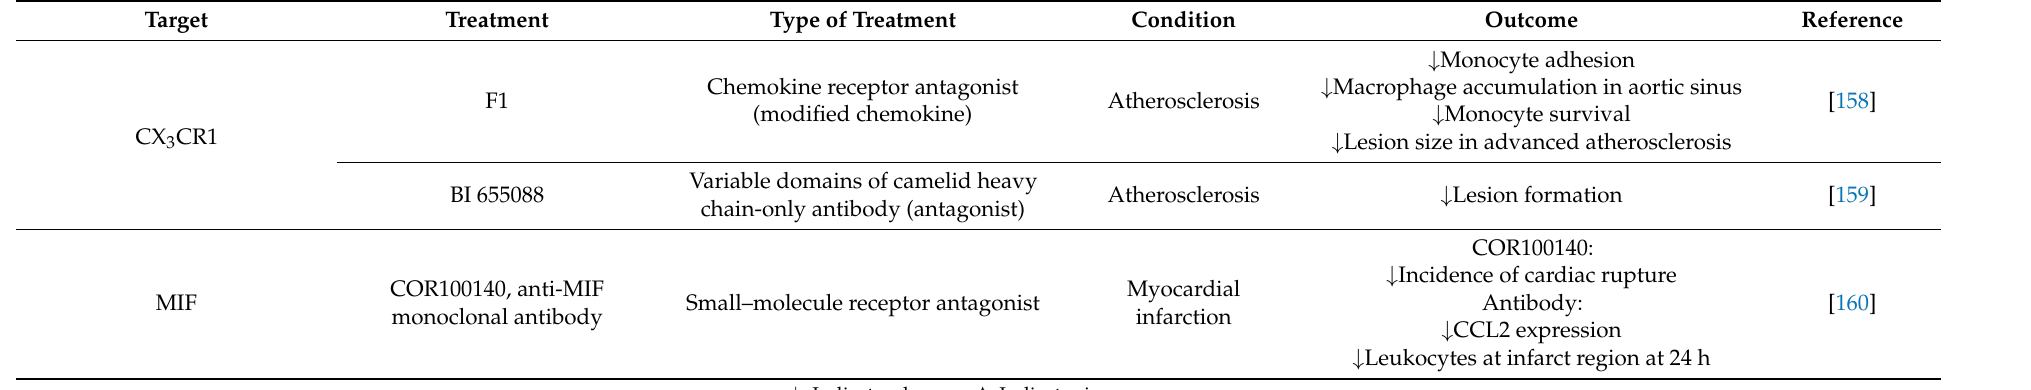
Table 2. Clinical trials registered on clinicaltrials.gov (accessed on 22 July 2021) and clinicaltrialsregister.eu focusing on treating CVDs by targeting chemokines and chemokine receptors.